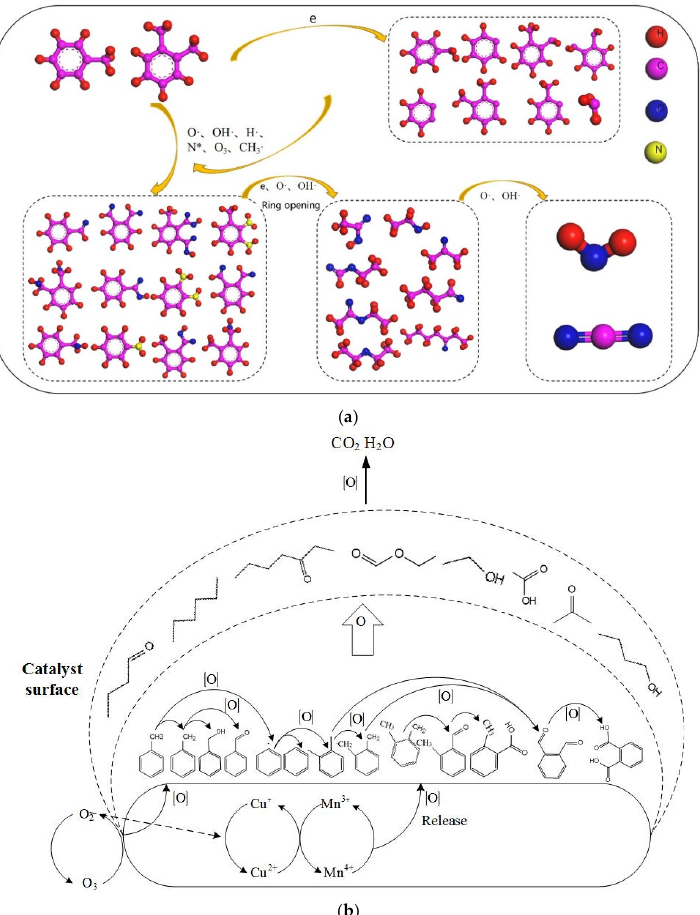
Figure 9. Degradation pathway of toluene and o-xylene under plasma catalysis system. ( a ) The reaction of VOCs in the gas phase ( b ) The reaction of VOCs on the surface of the catalyst.